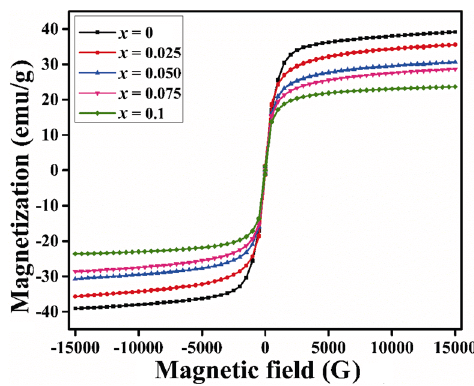
Fig. 5 Variation of magnetization with magnetic field at room temperature for Mn 0.5 Zn 0.5 Gd x Fe 2– x O 4 ( x = 0, 0.025, 0.050, 0.075, and 0.1) nanoparticles.